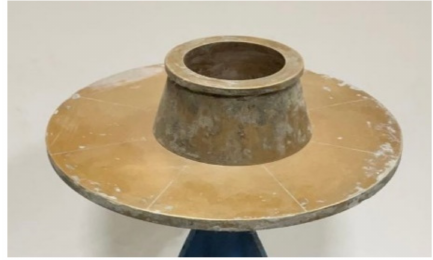
Figure 3. Mortar flow test